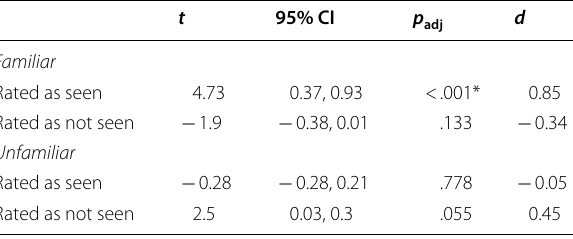
One sample t tests comparing the sensitivity ( d ′ ) with zero *Marks statistically significant results. Results are shown separately for cases in which participants rated the faces as seen or not seen in the study phase (Question